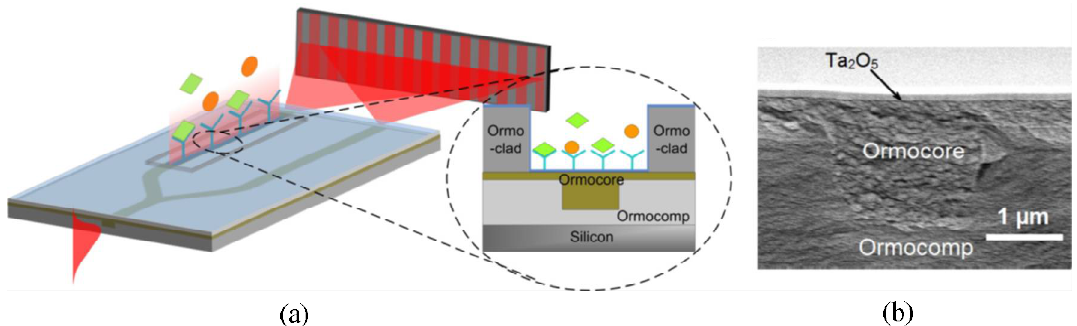
Figure 30. ( a ) Schematic image of the integrated YI biosensor based on inverted-ridge waveguide; ( b ) cross-section SEM image of the inverted ridge waveguide [88]. Copyright 2012 OSA.